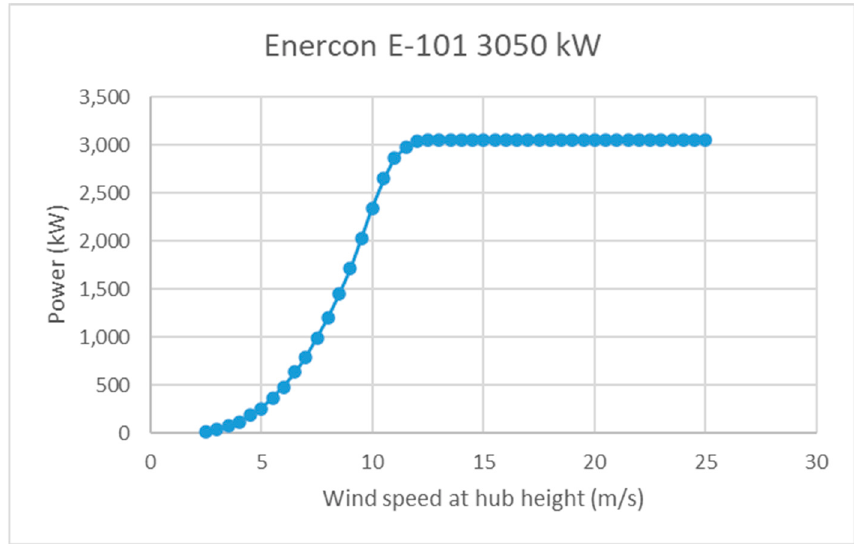
Figure 7. Power curve of Enercon E-101 of 3050 kW. Table 2. Power curve of each wind turbine.